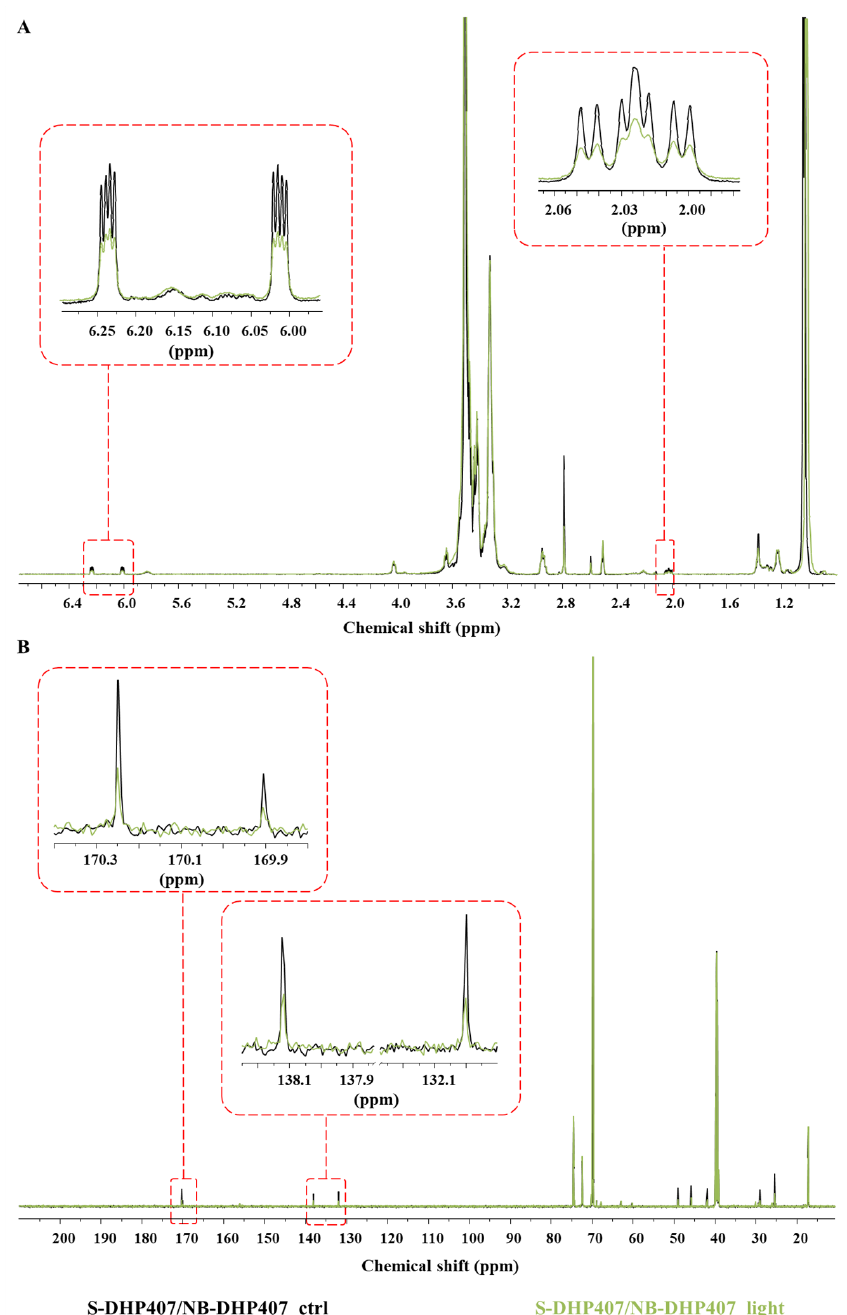
Figure 11. 1 H NMR spectra of S-DHP407/NB-DHP407_light (light green) and S-DHP407/NB- DHP407_ctrl (black) samples ( A ). Magnified inserts highlight differences in the set of signals between 2.0 ppm and 2.05 ppm corresponding to the aliphatic protons of norbornene molecules, and the bands at 6.0–6.2 ppm due to protons involved in norbornene double bonds. 13 C NMR spectra of S-DHP407/NB-DHP407_light (light green) and S-DHP407/NB-DHP407_ctrl (black) samples ( B ). Magnified inserts evidence changes in the signals at 132 ppm and 138.2 ppm ascribed to the carbons of norbornene double bonds, the peak at 170.3 ppm ascribed to the resonance of the carbonyl group involved in the amide bond between PEU and TGA preserving the free –SH groups, and the band at 169.9 ppm attributed to the carbonyl group involved in the amide bonds formed with TGA molecules converted in the S-S